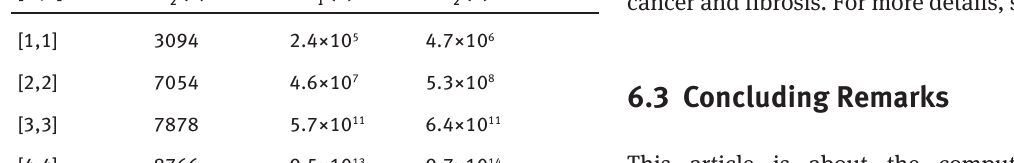
Table 6: A comparison of Zagreb coincides and multiple indices for SiC - III [ n,m ]. 3 [m,n] M